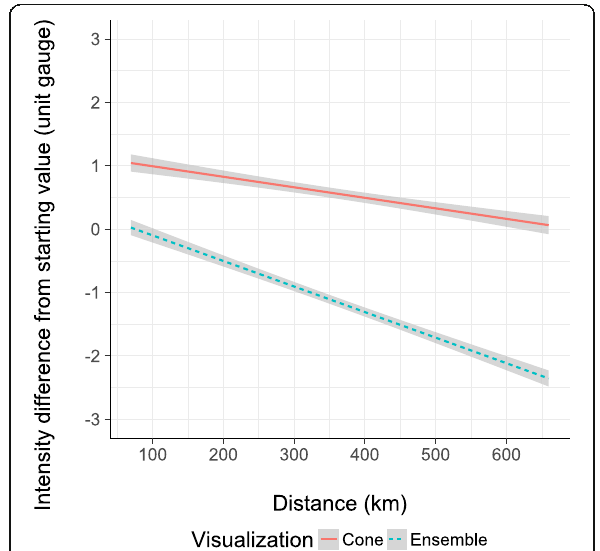
Fig. 7 Simple slopes of the interaction between distance and visualization type on change in intensity judgments. Grey shading indicates±1 standard error. Accurate interpretation would be indicated by a ‘ 0 ’ change score. A one-unit change represents a one-step change in gauge intensity along a 9-point scale (see Fig. 4 for the 9-point